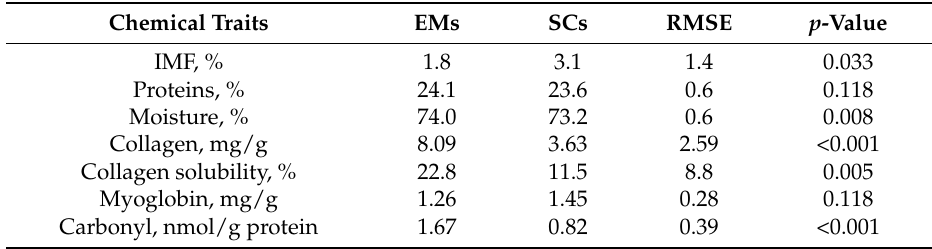
Table 2. Chemical composition of the longissimus dorsi, pars lumborum muscle according to sex group. Chemical Traits